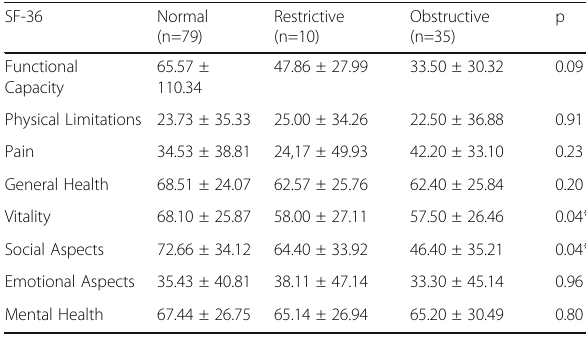
Table 71 (abstract A212). Results of